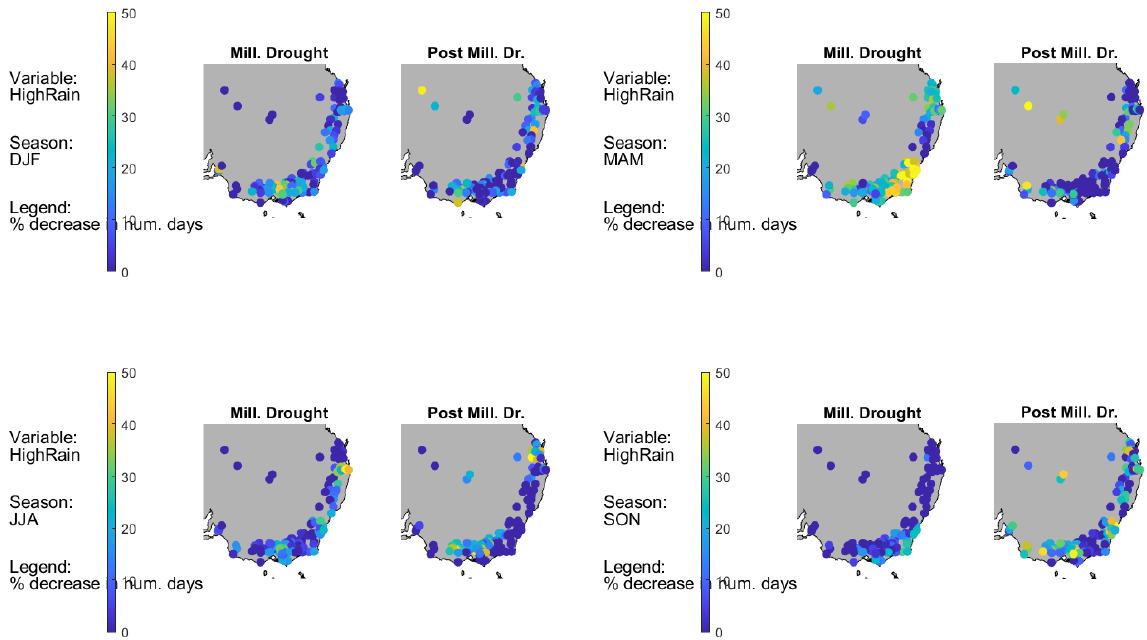
Figure D3. Same as Fig. D1 except for the number of high rainfall events (see Fig. 3 for high rainfall definition). Based on data from Fowler et al. (2021).